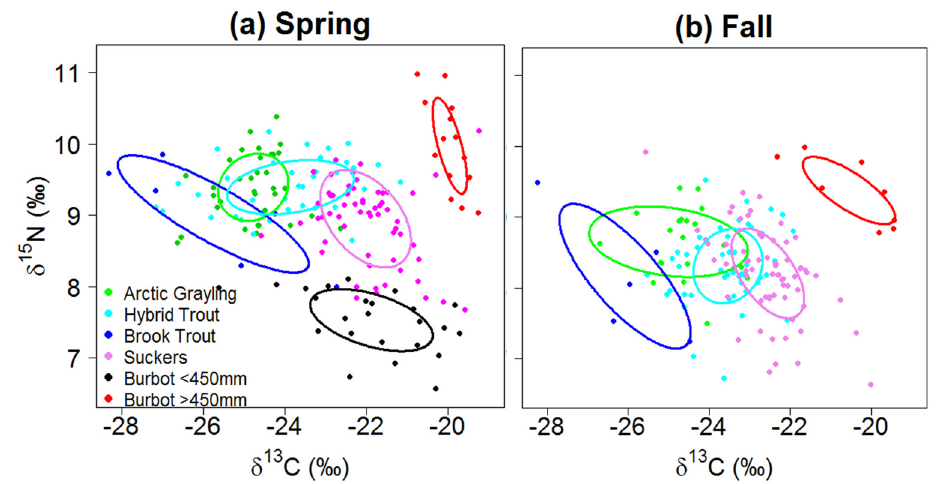
Fig 5. Stable isotope Bayesian ellipses (solid lines) depict trophic niche breadth and overlap in the spring (a) and fall (b) based on SEA c analysis for Arctic grayling, large burbot ( > 450 mm), small burbot ( < 450 mm), hybrid trout, sucker, and brook trout. Each point represents an individual fish. Only one small burbot was captured in the fall, preventing quantification of population niche metrics.